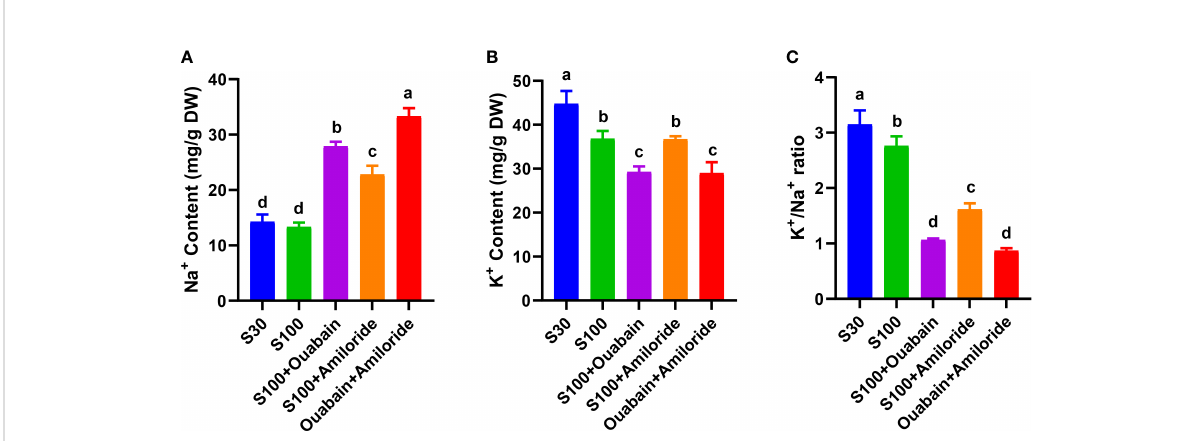
FIGURE 4 Effects of ouabain and amiloride on Na + content (A) , K + content (B) , and K + /Na + ratio (C) in thalli under hypersaline stress (100 ‰ , 15 min). DW: dry weight of thalli. S30: control salinity (30 ‰ ). S100: hypersaline stress (100 ‰ ). Values shown are average of three individual thalli. Bars represent the standard error of the mean ( n = 3). Different letters indicate signi fi cant differences ( P< 0.05) among